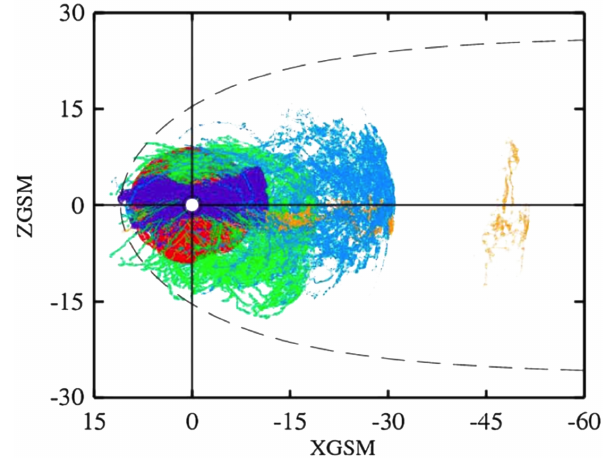
Figure 11. Location of magnetic measurements made by Polar (red), Cluster (green), Geotail (light blue) and THEMIS (dark blue and light brown) to produce the new Tsyganenko model (from Tsy- ganenko,